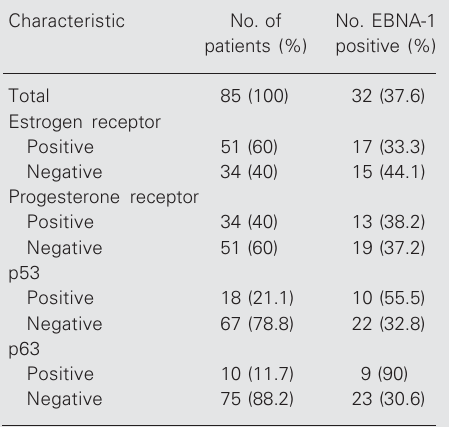
Table 2. Correlation of Epstein-Barr virus EBNA-1 with hormonal status and p53 and p63 expression in breast